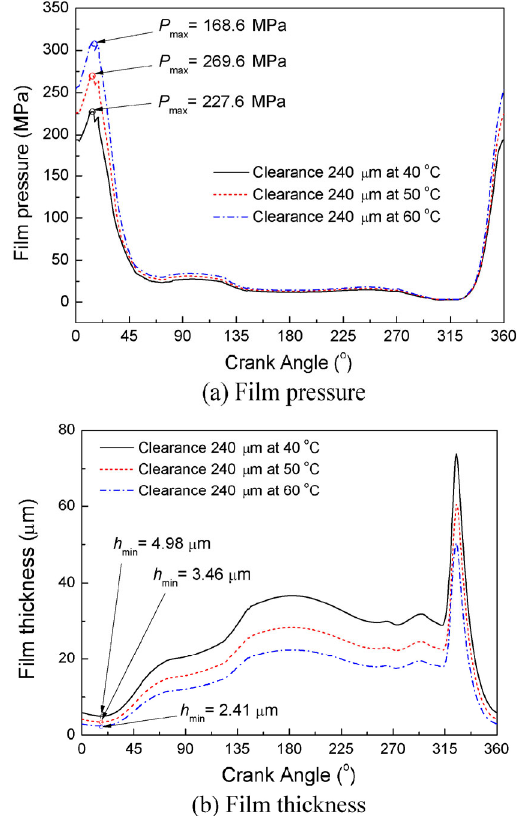
Fig. 9 Pressure and film thickness with the crank angles for the crank pin bearing with three different clearances and a lubricant temperature of 40 ° C.